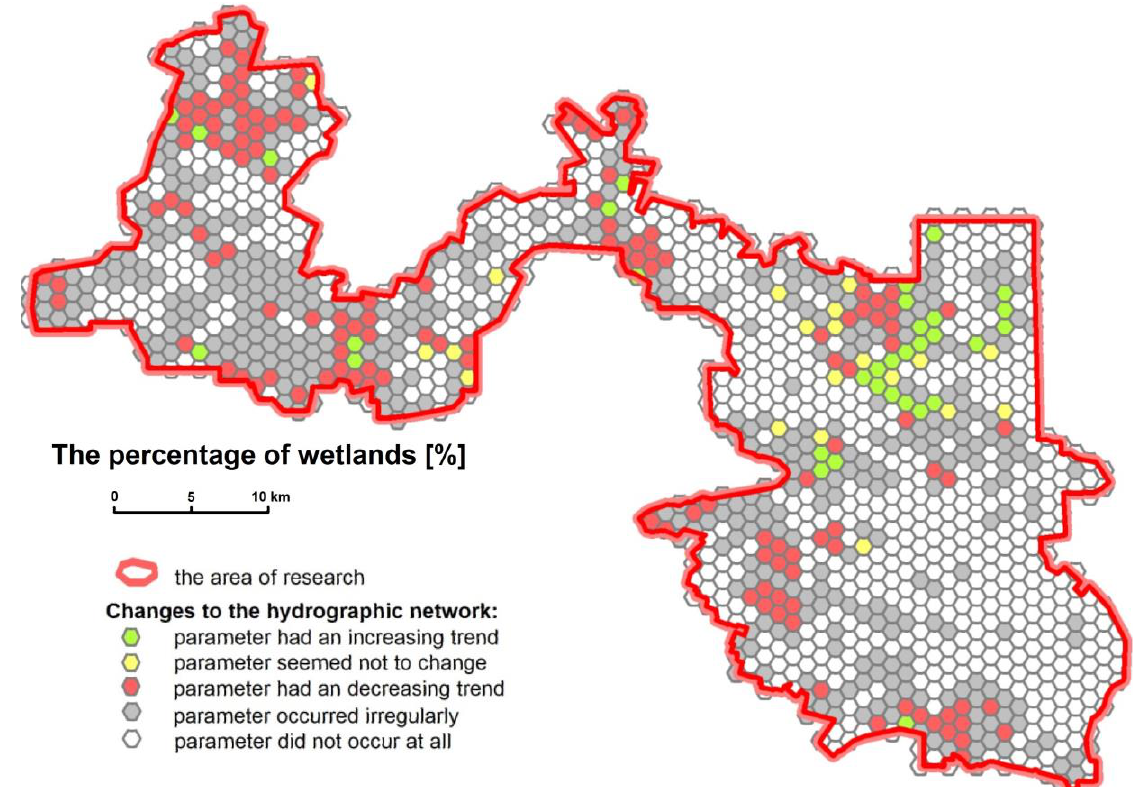
Fig. 3. Map of changes to the percentage of wetlands (A – the beginning of the 19 th century, B – the end of the 19 th century, C – the beginning of the 20 th century, D the end of the 20 th century, E ¬ the beginning of the 21 st century; own study based on the created